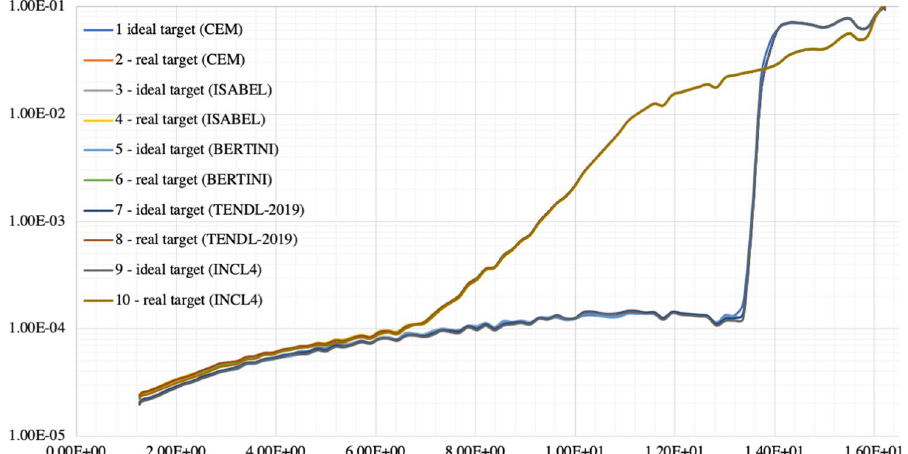
Figure 4. Proton spectra in the target volume. Y axis, intensity [a.u.], X axis, energy [MeV]. As it can be seen, from the ideal and the real target, the tallied spectra remain coherent between models and cross